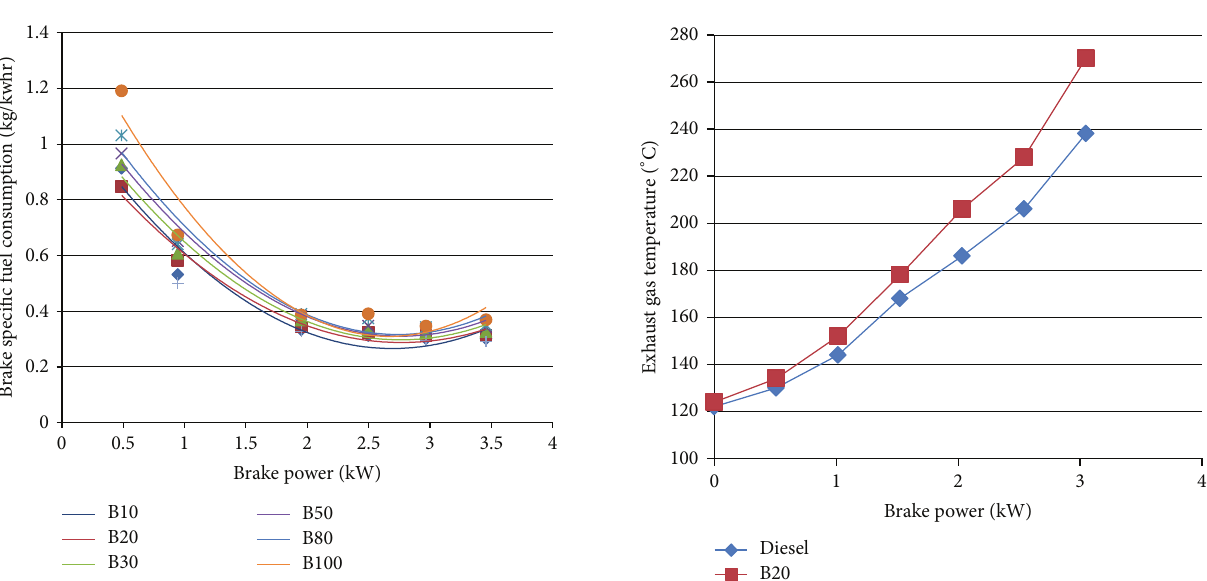
Figure 12: Exhaust gas temperature versus brake power.